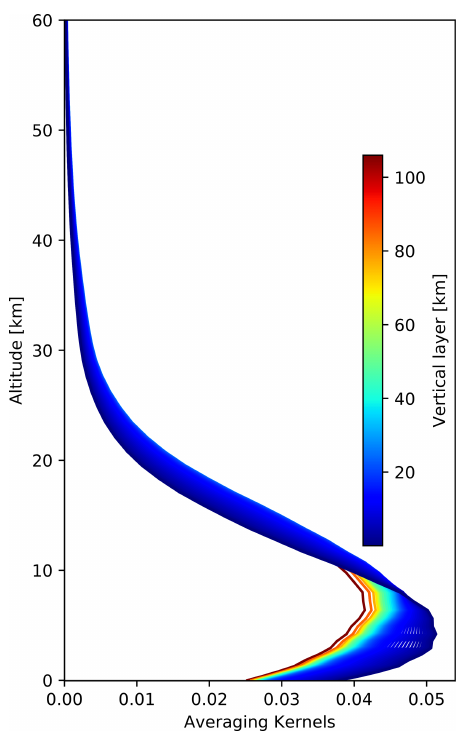
Figure 4. Typical averaging kernels of the HFC-23 retrieval for the same spectrum shown in Fig. 3, which are normalized using the a priori profile. Note that the vertical scale is from the surface up to 60km because there is almost no sensitivity above